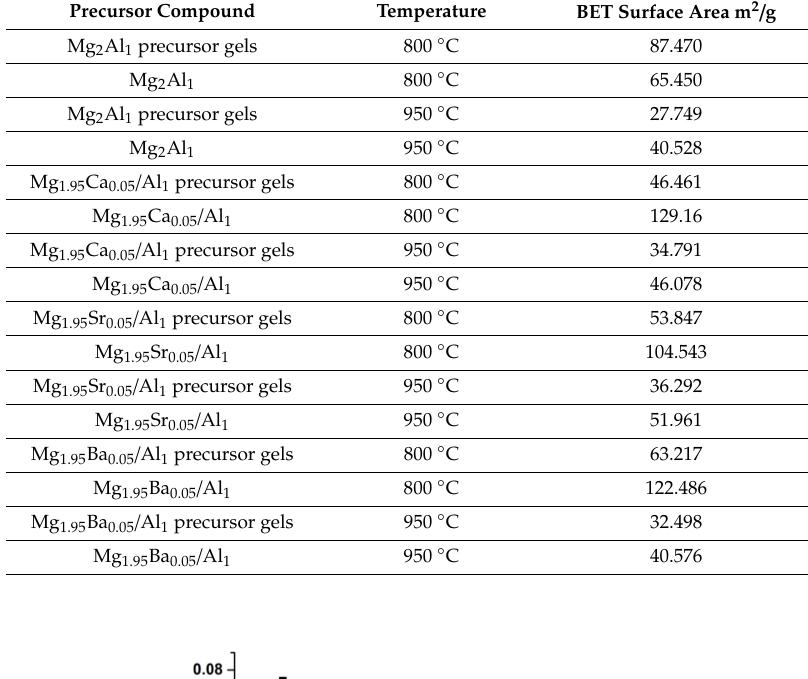
Table 2. Brunauer, Emmett and Teller (BET) surface area of sol–gel derived Mg 1.95 M 0.05 / Al 1 (M = Ca, Sr and Ba) MMO.